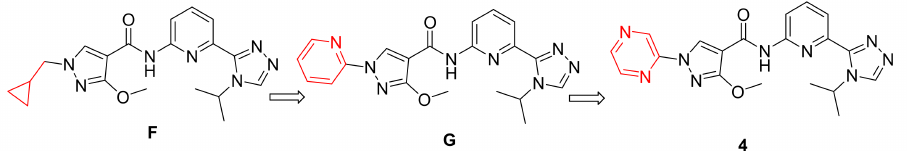
Figure 14. A scheme depicting compounds F , G , and 4